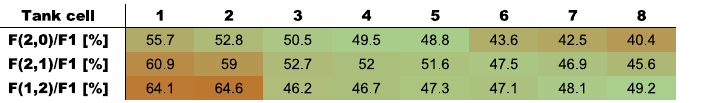
Figure 17. Estimation of sloshing mode frequencies for the 50% filling level case for each MiniWoT tank cell, shown as a percentage of F 1. Values coloured by their proximity to 50%.